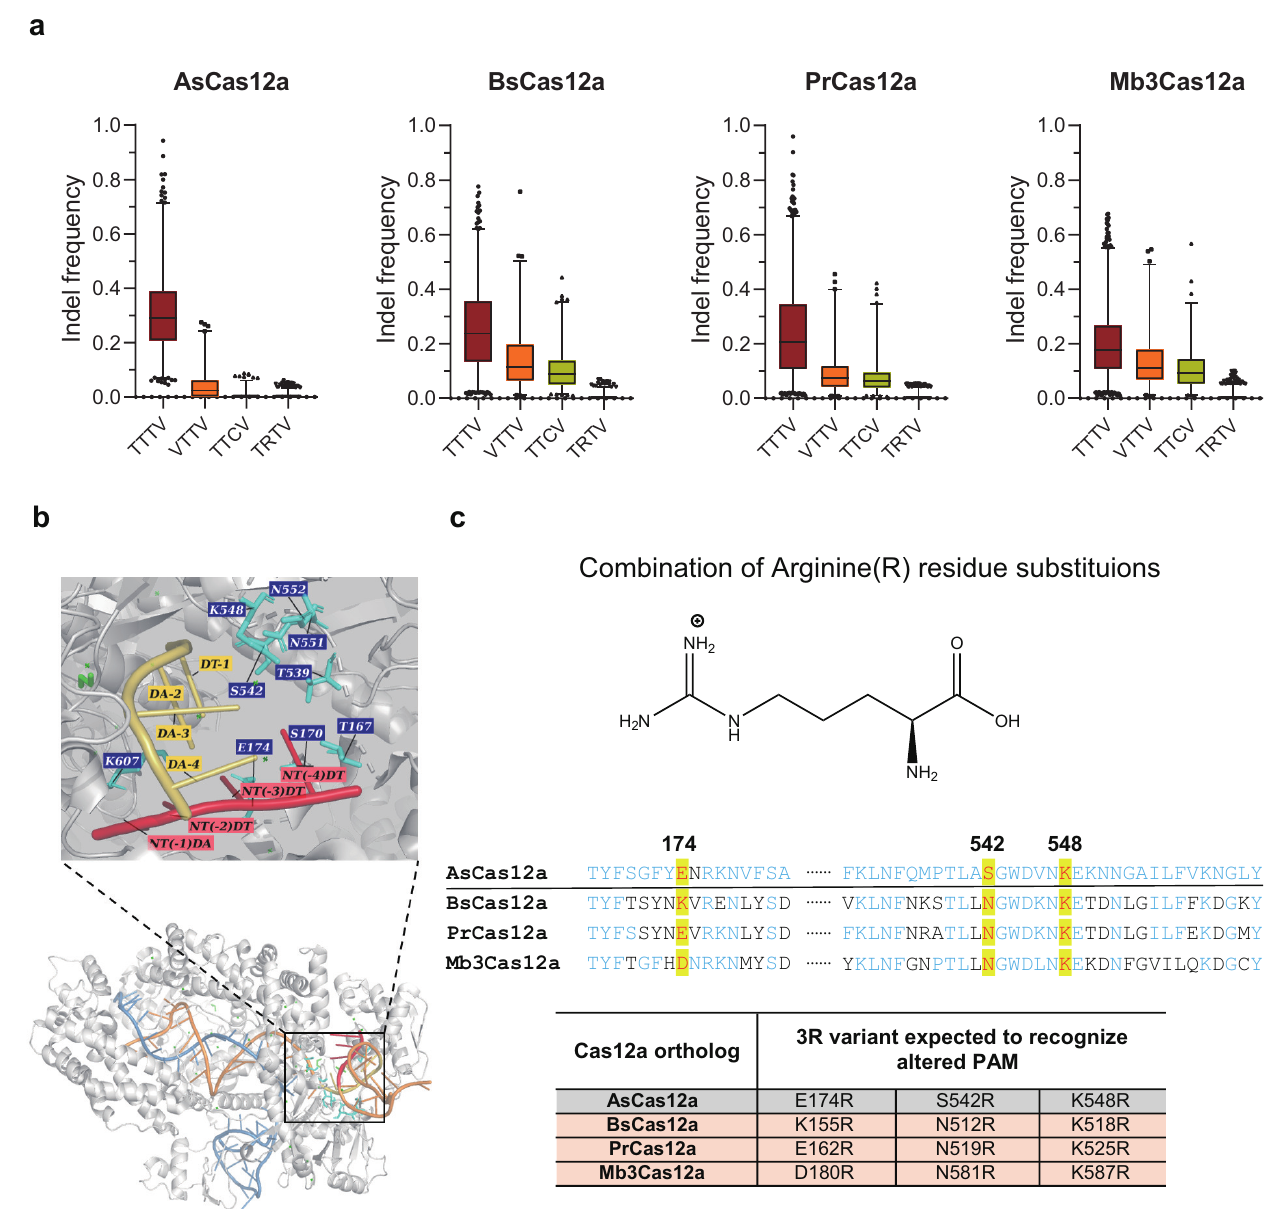
Figure 3. Engineered Cas12a variants with three arginine substitutions for enhanced editing activity and expanded PAM compatibility. ( a ) Editing activity assessment of four wild-type Cas12a (AsCas12a, BsCas12a, PrCas12a, and Mb3Cas12a) on targets with canonical and non-canonical PAMs. Box-whisker plots: median line, quartiles for box edges, 1–99% whiskers. ( b , c ) Structure-guided mutation design of three Cas12a variants for a wider PAM recognition range. ( b ) Structural representation of the AsCas12a (gray)–crRNA(orange)–target dsDNA(blue) ternary complex. The structural image was generated from PDBID:5B43 and visualized in PyMOL(version 2.1.0) [40] (Adapted with permission, Copyright © 2016, Elsevier). ( c ) Positive arginine residue and 3R variant design of the four Cas12a orthologues for an expanded target range. ( top ) Amino acid sequence alignment of the four Cas12a orthologues flanking the three PAM-proximal residues (E174, S542, and K548 in AsCas12a) verified as contributing to improved editing activity and a wider recognition range of AsCas12a, named enAsCas12a-HF (E174R/N282A/S542R/K548R) [27]. The yellow highlights with red letters represent mutation sites, blue letters represent a match with AsCas12a, and the black letters represent a mismatch with AsCas12a. The position numbers on top refer to the amino acid sequences of AsCas12a. ( bottom ) Three engineered Cas12a variants for enhanced editing efficiency and expanded target range. For more details, see the Supplementary